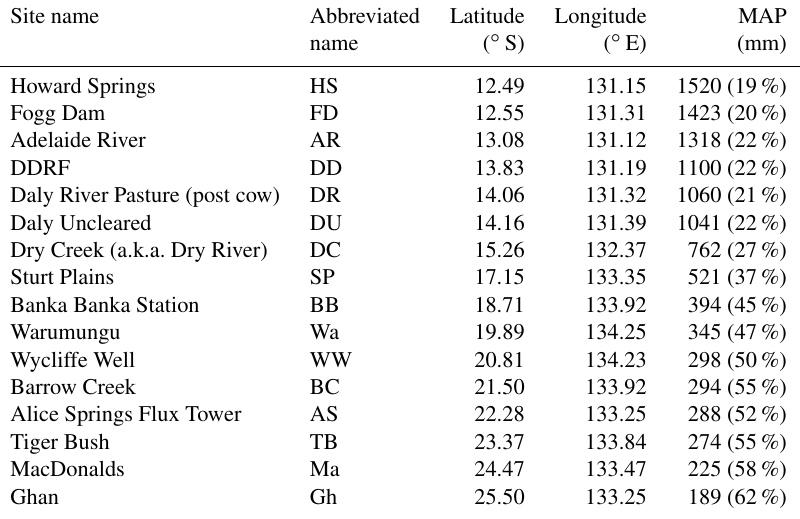
Table 1. Names, locations and mean annual precipitation (MAP) for sites along the North Australian Tropical Transect. Values in brackets show coefficients of variation. MAP from AWAP data from 1900 to 2010.